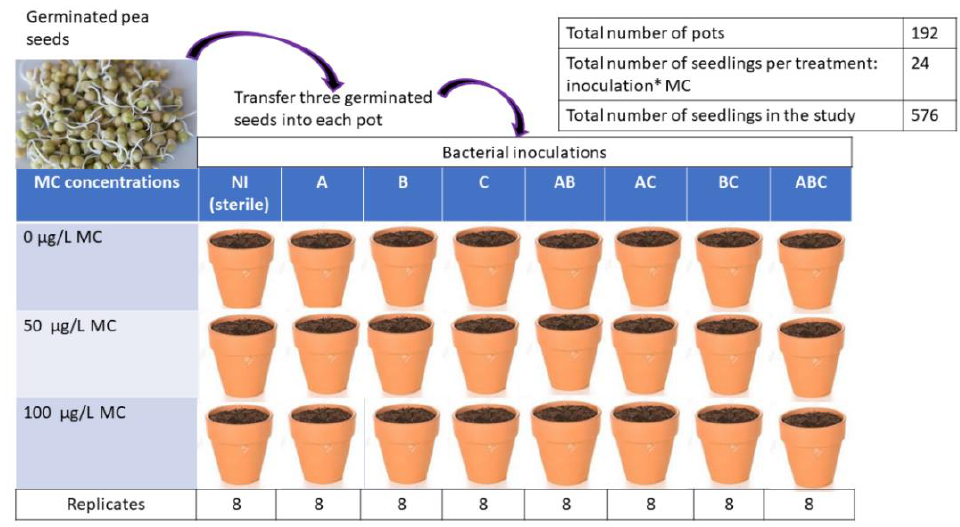
Figure 1. Experimental design for pea bacterial addition and MC treatment.